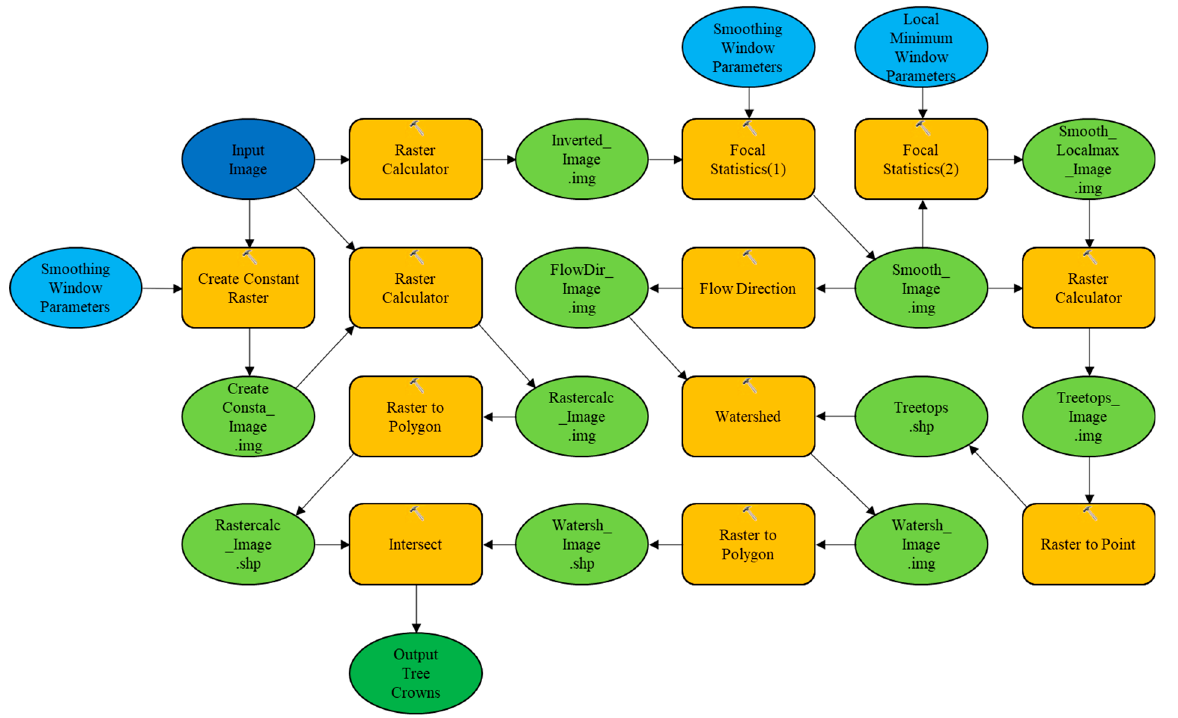
Figure A3. The MCWS algorithm workflow for individual tree detection using ModelBuilder. The input file is shown in dark blue color; the input parameters are shown in light blue color; the ArcGIS tools are shown in yellow color; the intermediate data is shown in light green color; and the output result is shown in dark green color.